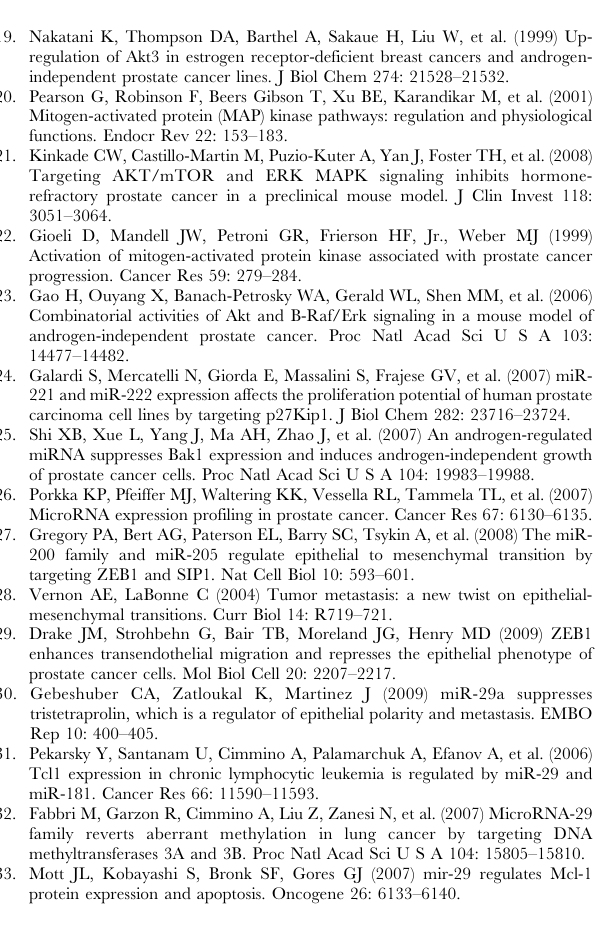
Table S3 The GO term predicted targets of differen- tially expressed miRNAs. Table S4 The KEGG term of predicted targets of differentially expressed